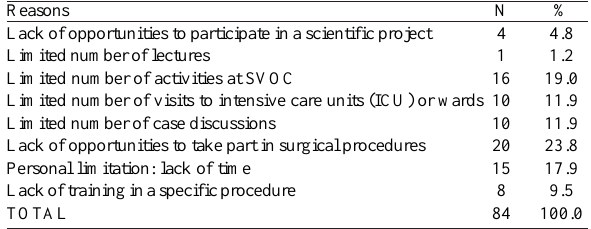
Table 2. Reasons given for not meeting their initial expectations when joining LCCT.